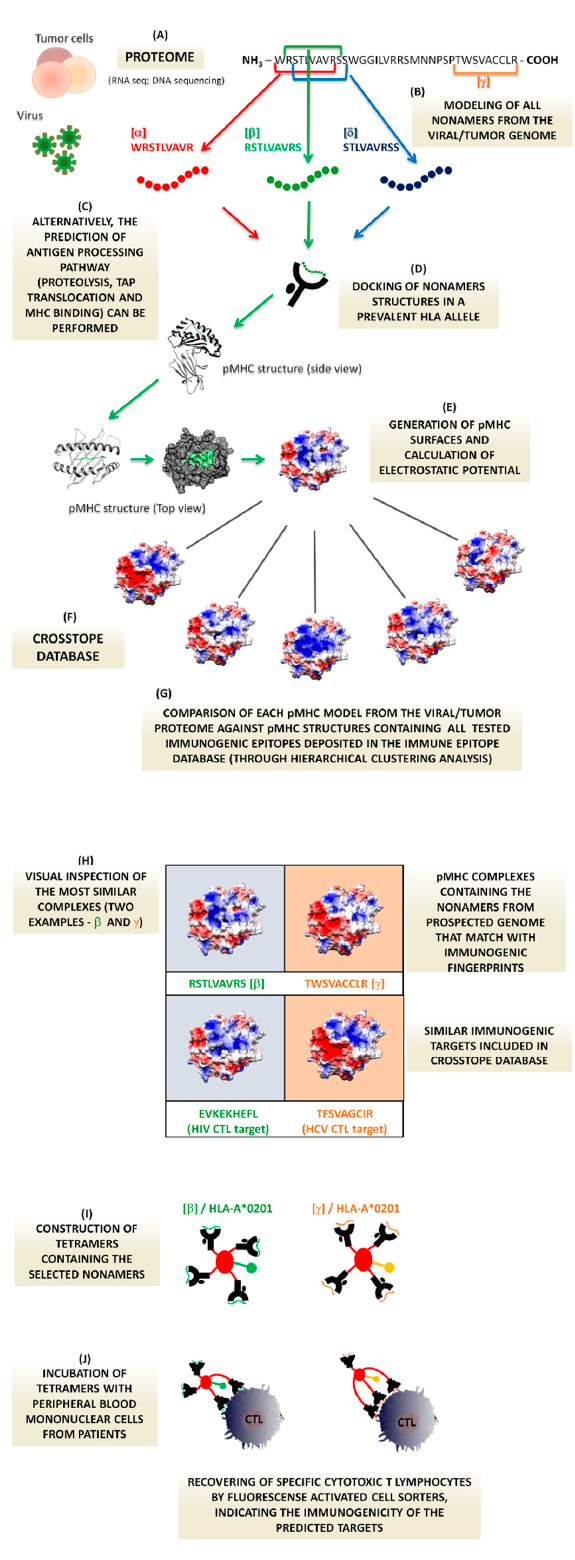
Figure 1. ( A ) From the sequencing of both DNA or RNA from tumor cells or viruses, it is possible to infer the proteome from these samples. ( B ) These protein sequences can be decomposed into